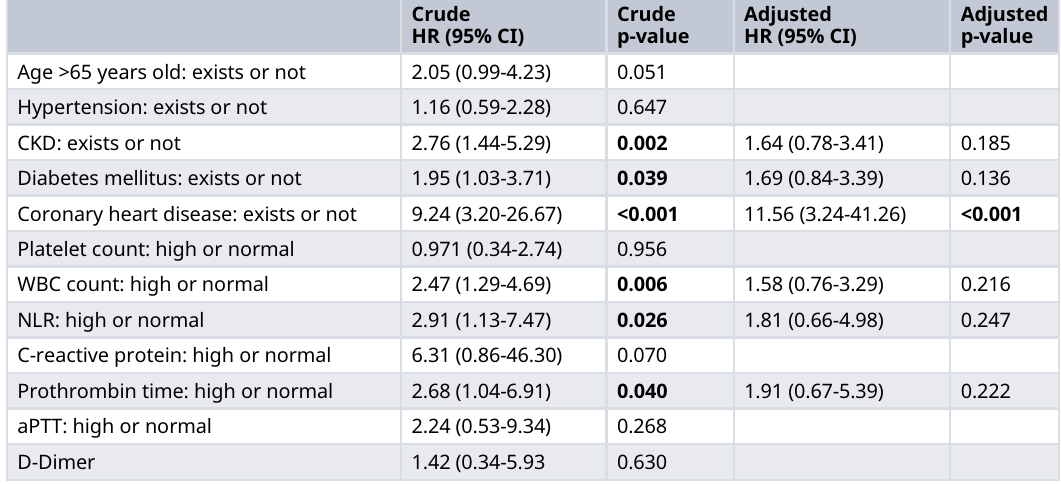
Table 4. Multivariate with Cox regression